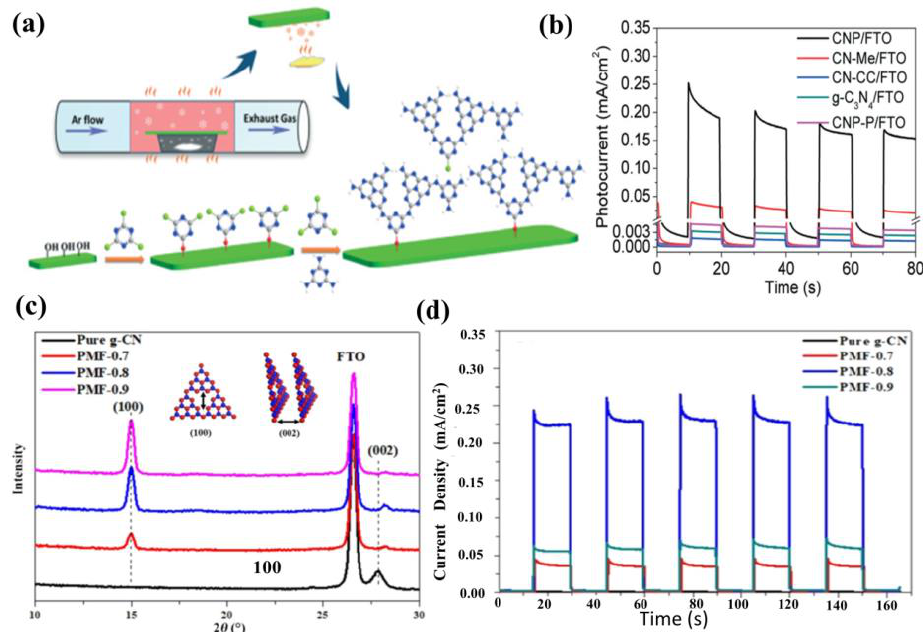
Figure 12. ( a ) Schematic illustration of the synthesis of the g−CN film with a triazine – heptazine network, and ( b ) photocurrent (i – t curve) of g−CN film chopping in 0.5 M Na 2 SO 4 under simulated solar irradiation. Reprinted with permission from ref. [130] Copyright 2019 Royal Society of Chemistry. ( c ) XRD patterns of pure g−CN and tailored films, and ( d ) transient photocurrent response in 0.2 M Na 2 SO 4 at 1.23 V vs. RHE. Reprinted with permission from ref. [131] Copyright 2018 Wiley-VCH.